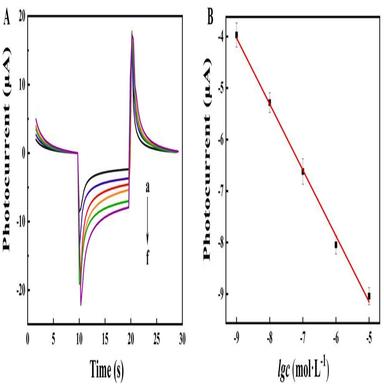
(A) The PQ-concentration dependent photocurrent responses of the ITO/Au/Cu2O electrode. From a to f remarks the concentration range from 10-9 to 10-5 mol L-1, and (B) the corresponding calibration linear curve.